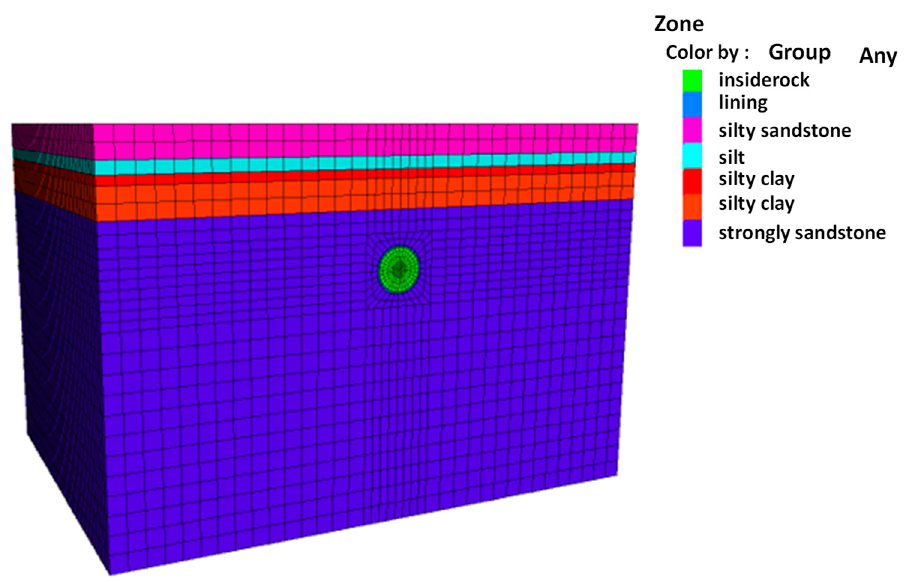
Figure 9. The soil profile along Section Figure 8. The soil profile along Section 3.